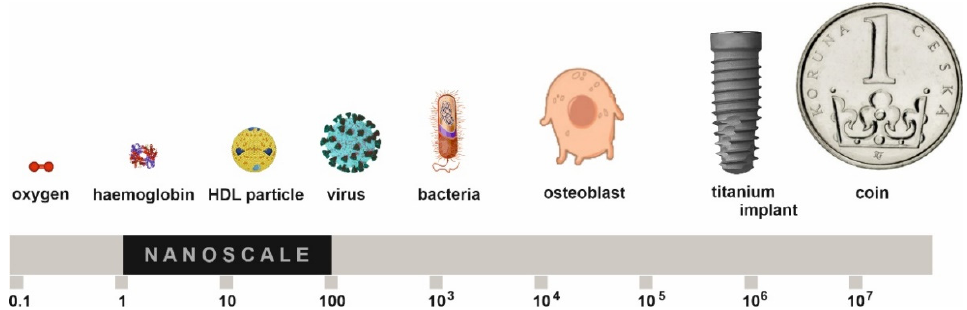
Figure 1. Metric scale in nanometers, in which the nanoscale (1–100 nm) is compared between the macro, micro, and nanoworlds. The images are not in a comparable